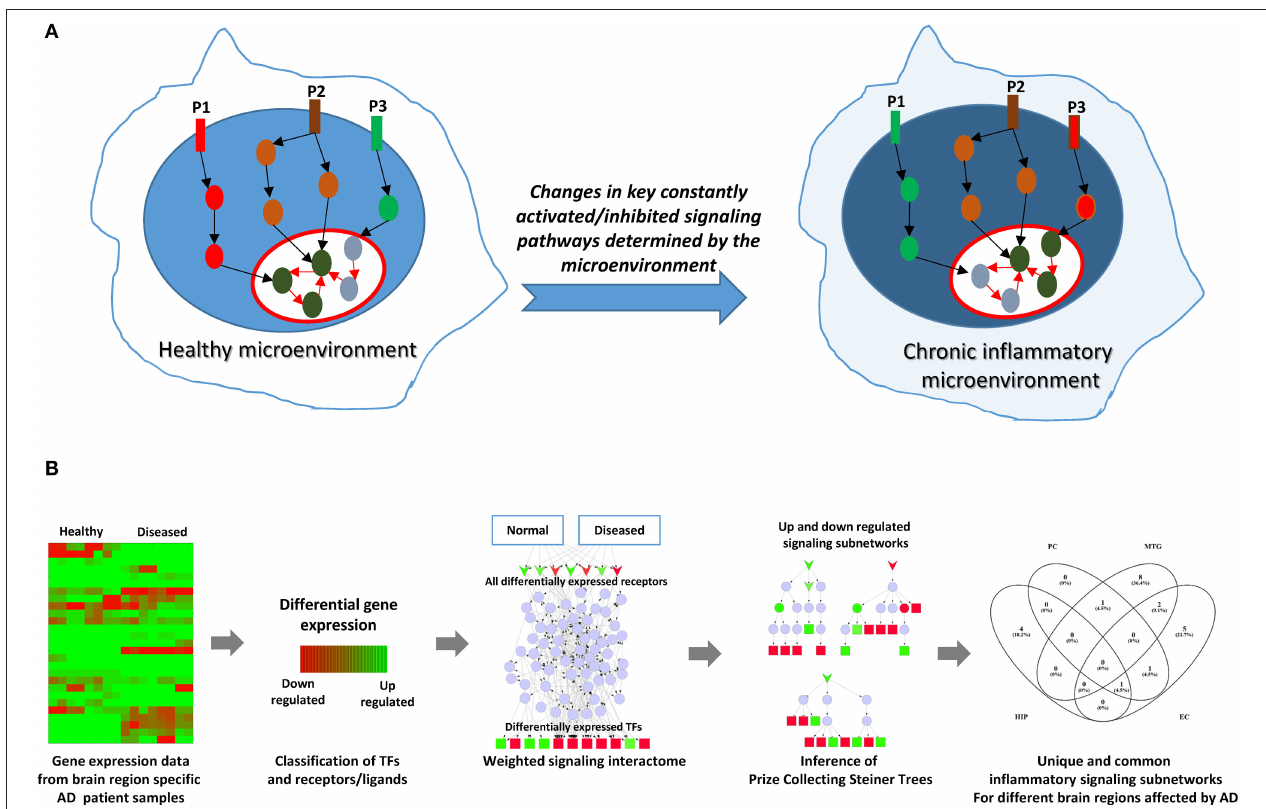
FIGURE 1 | Rationale and the schematic of the computational approach employed. (A) Depicts the rationale of the computational network analysis presented in this study. Cellular microenvironment exerts a constant effect on certain key signaling pathways and maintain them constantly active or inactive. Pathways P1, P2, and P3 denote such constantly activated/inhibited signaling pathways under normal healthy conditions and under chronic inflammation. P2 is a pathway commonly active in both conditions. However, P1 is active (upregulated) only in healthy microenvironment while it gets inhibited (downregulated) under chronic inflammation. On the other hand, P3 is activated under chronic inflammation while P1 gets downregulated. The goal in this study is to identify such constantly activated/inhibited signaling pathways as consequence of inflammation in AD affected in different regions of brain. (B) Represents the overall schematic if the analysis employed in the